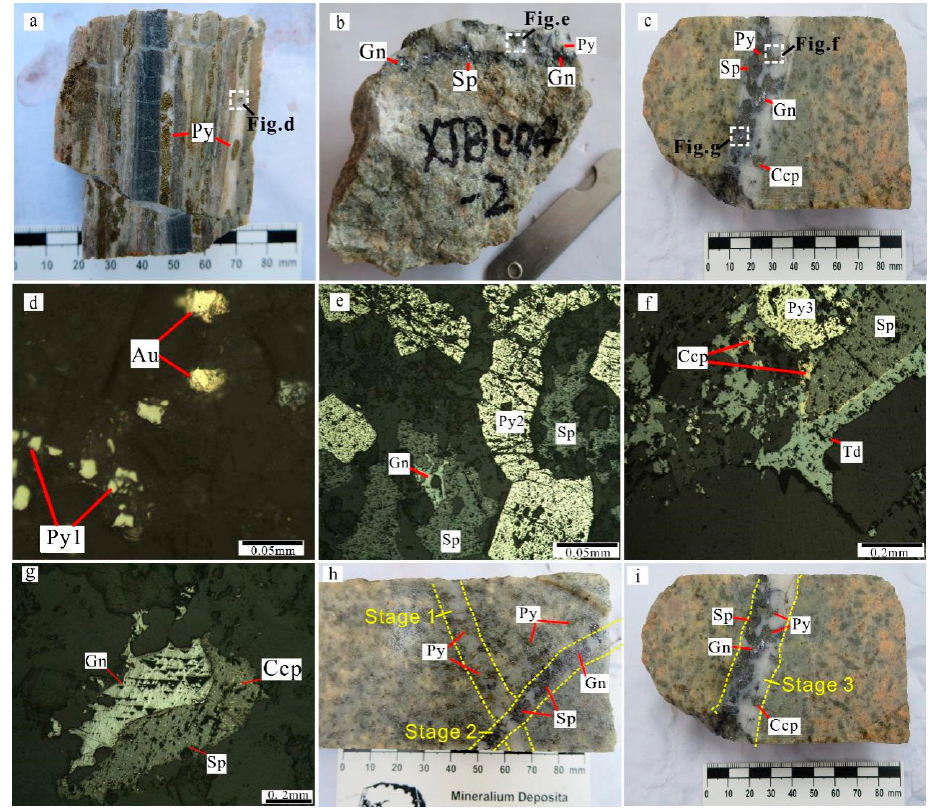
Figure 4. Mineral assemblages at the Xiajinbao Au deposit. ( a ) Banded auriferous pyrite–quartz–vein- type ores; ( b ) Galena–sphalerite–quartz–vein-bearing altered granitic porphyry; ( c ) Poly sulfide (pyrite, chalcopyrite, tetrahedrite, galena, sphalerite)–quartz-bearing altered granitic porphyry; ( d ) Native–gold–pyrite-bearing quartz vein; ( e ) Sphalerite replacing hypidiomorphic–allotriomorphic pyrite and replaced by galena; ( f ) Sphalerite replacing hypidiomorphic–allotrimorphic chalcopyrite, chalcopyrite replacing sphalerite, tetrahedrite replacing sphalerite and chalcopyrite; ( g ) Common intergrowth texture between galena and sphalerite; ( h ) Galena–sphalerite–quartz vein-cutting pyrite– quartz vein; ( i ) Poly sulfides (pyrite, chalcopyrite, tetrahedrite, galena, sphalerite)–quartz vein.